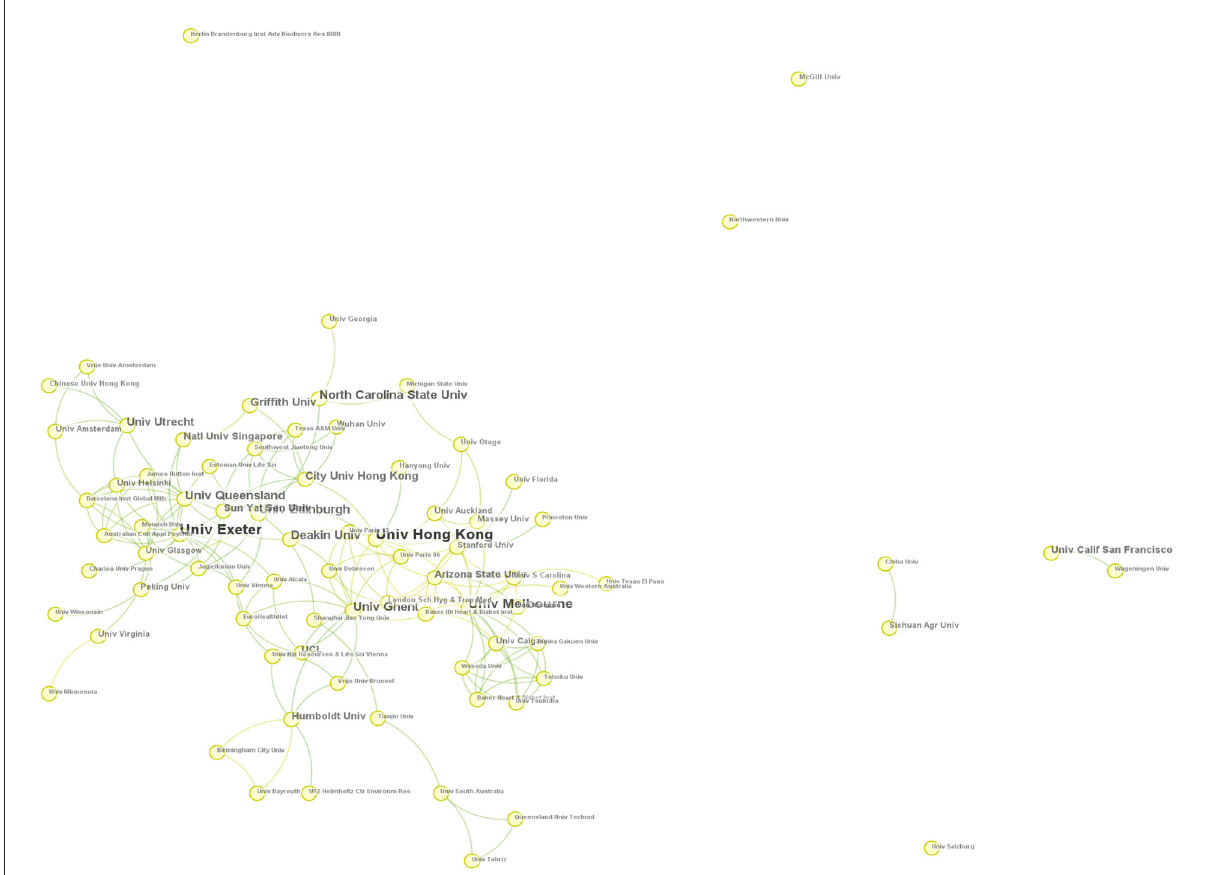
FIGURE4 Institutions of origin of articles.